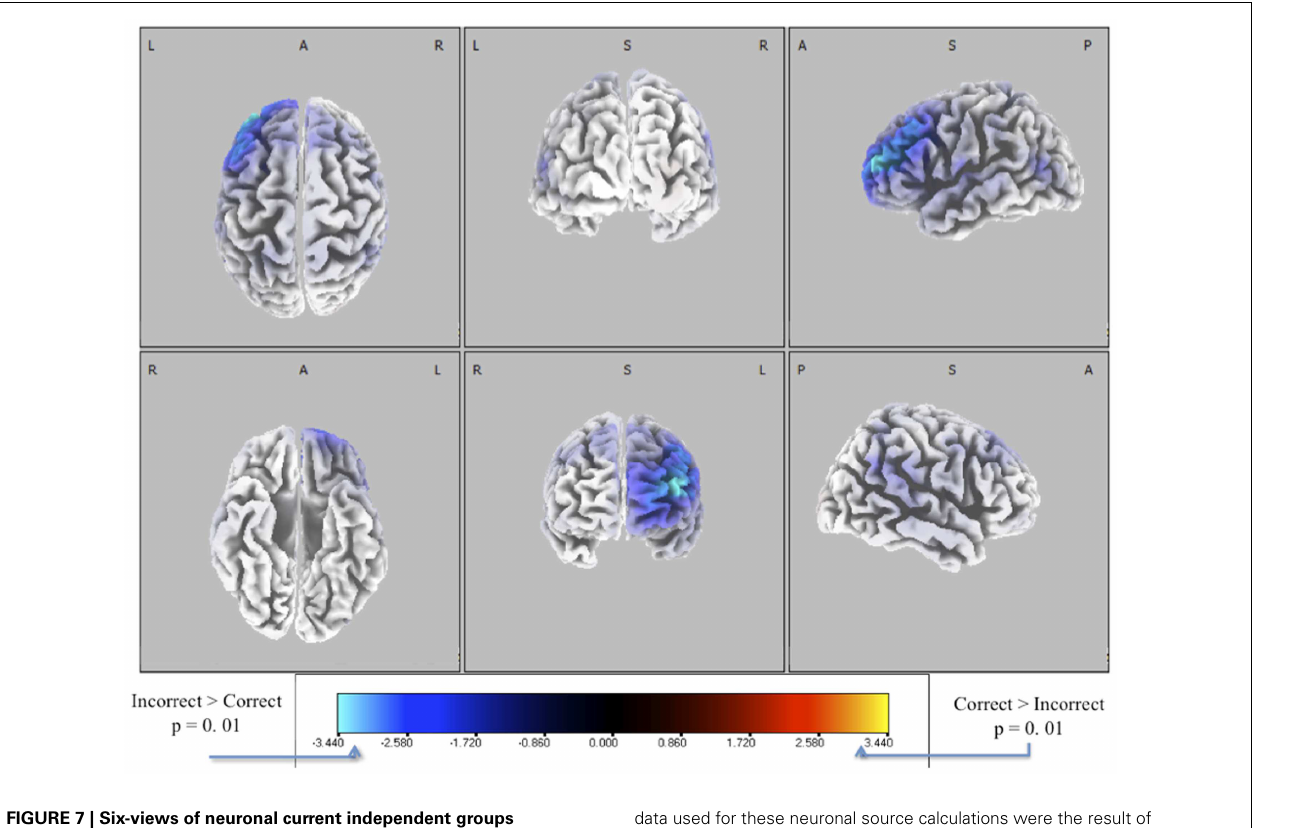
data used for these neuronal source calculations were the result of averaging scalp potentials at each channel at the subject-specific peak discrimination during the group average discrimination peaks.This analysis is done for each subject (one subject removed due to no errors in sliders), for both correctly and incorrectly identified pitches, and for each pitch